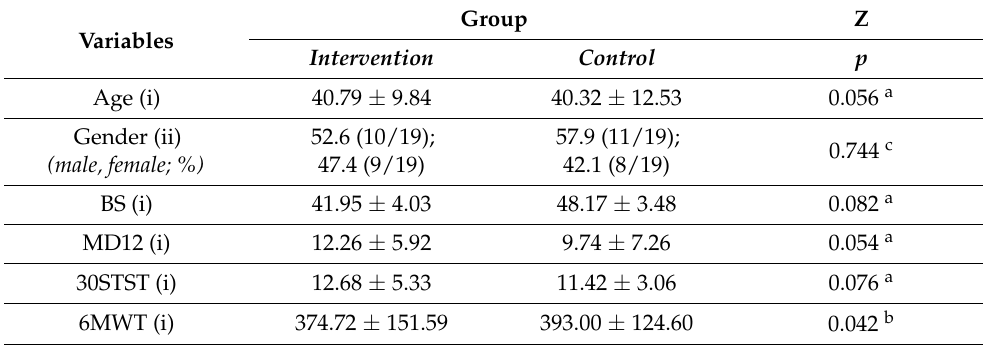
Table 1. Descriptive pre-intervention